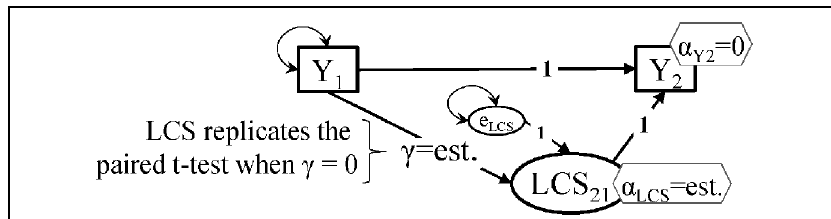
FIGURE 1 | Structural modeling setup for the paired t -test model and the latent change score (LCS) model with self-feedback/mediation (SF/M). Notes: significance of Y 1 to Y 2 changes is captured by the α LCS intercept; ‘est.’ means parameter is estimated by the model; intercepts are shown in hexagons, variances as double-headed arrows (covariance with itself); the key features of the LCS mode are: (1). No Y 2 residual error; (2). Intercept of Y 2 is set to zero; (3). The auto-regressive path is set to 1; the LCS to Y 2 path is set to